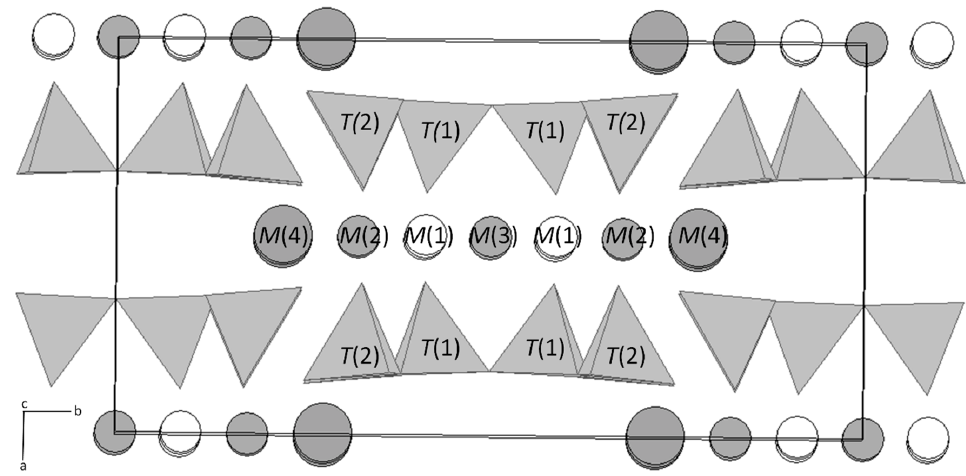
Figure 5. General view of the tremolite structure at room temperature (RT).